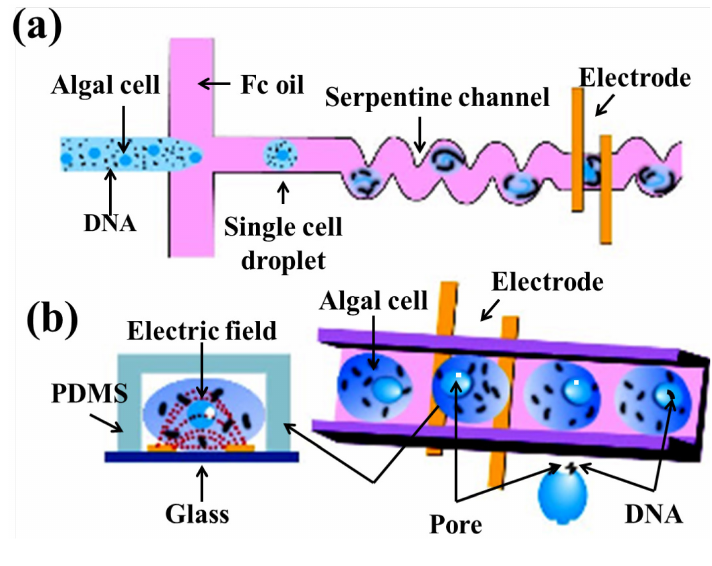
Figure 9. Droplet microfluidic electroporation technique ( a ) schematic diagram; ( b ) electroporation process of algal cell. Figure has been redrawn from reference